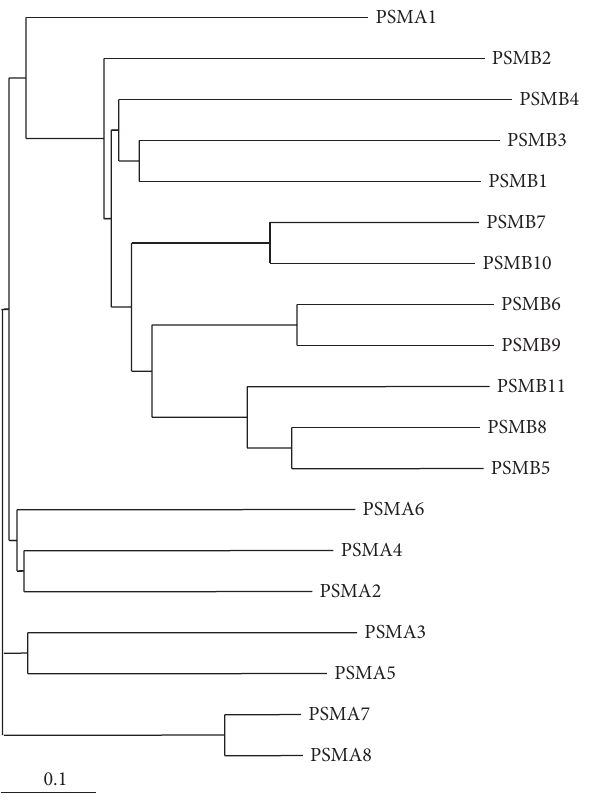
Figure 6: Phylogenetic tree of human 20S proteasome subunits. Phylogenetic tree was generated using Clustal W2 phylogeny [88] and image obtained using TreeView [89]. The UniProt accession numbers used for the alignment of proteasome subunits are given in Figures 4 and